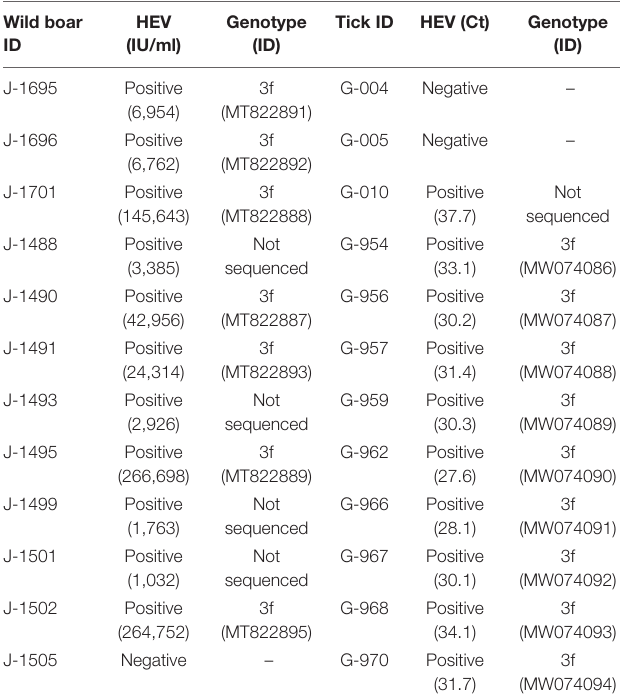
TABLE 1 | Distribution of hepatitis E-positive wild boars ( Sus scrofa ) and ticks ( Hyalomma lusitanicum ). Wild boar